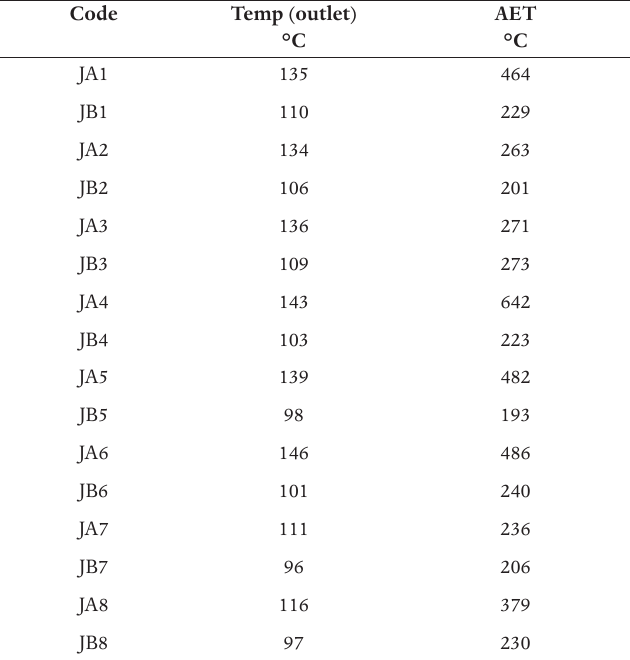
Table 3. Apparent equilibrium temperatures (AETs) for the chemical compositions of JA and JB.